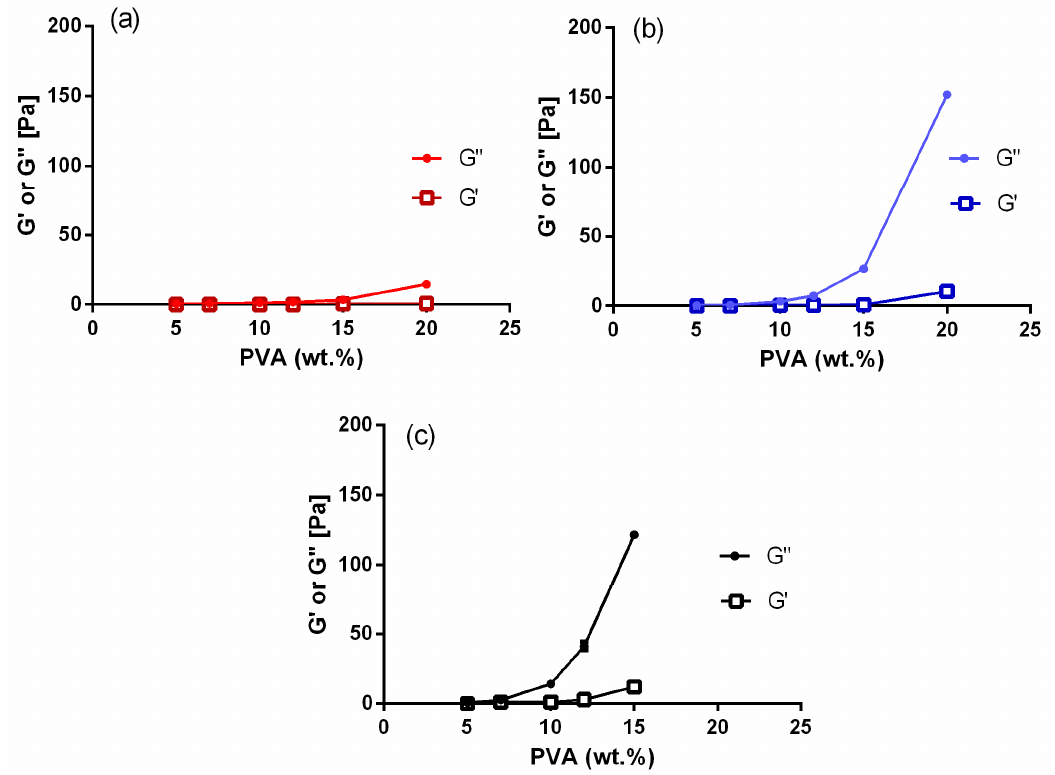
Figure 2. Storage (G ′ ) and loss (G ″ ) moduli as a function of PVA concentration (wt.%). ( a ) Low molecular weight (LMW), ( b ) medium molecular weight (MMW) and ( c ) high molecular weight (HMW) (error bars are smaller than the symbol size).